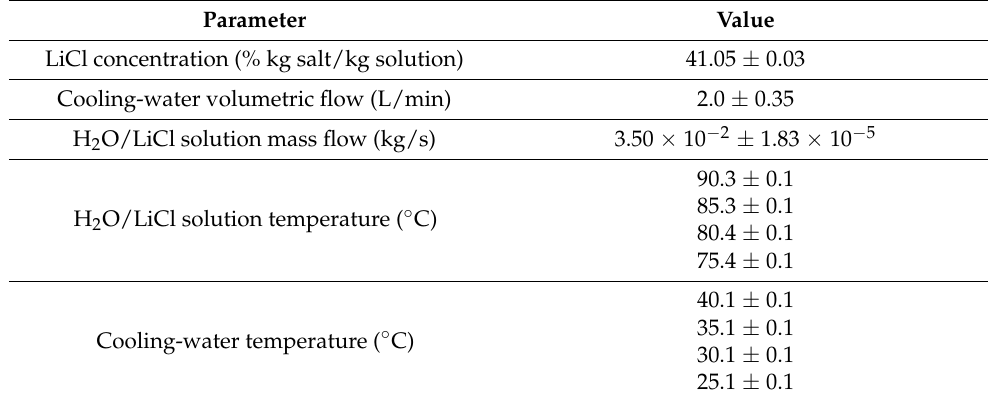
Table 3. Experimental operating conditions in continuous operation